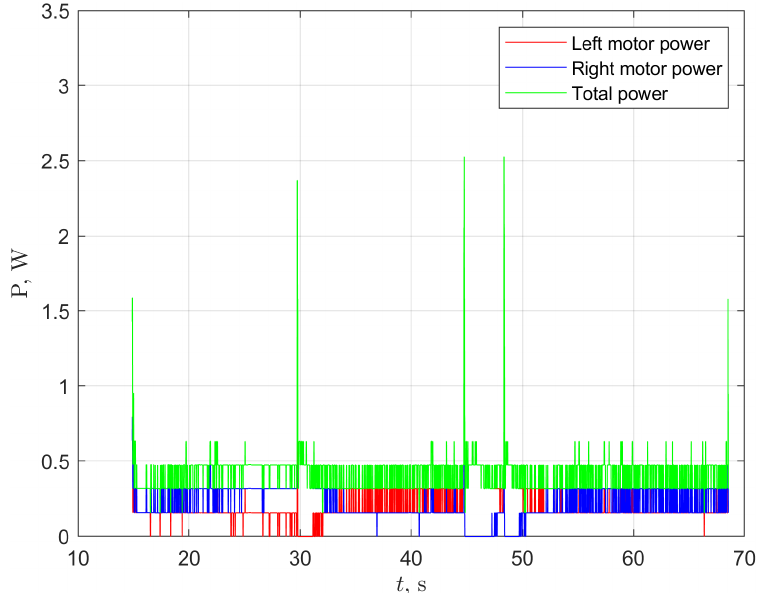
Figure 28. Individual motor power and the total power over time, for the mid value of the cost function equal to 1.0858—track 2.